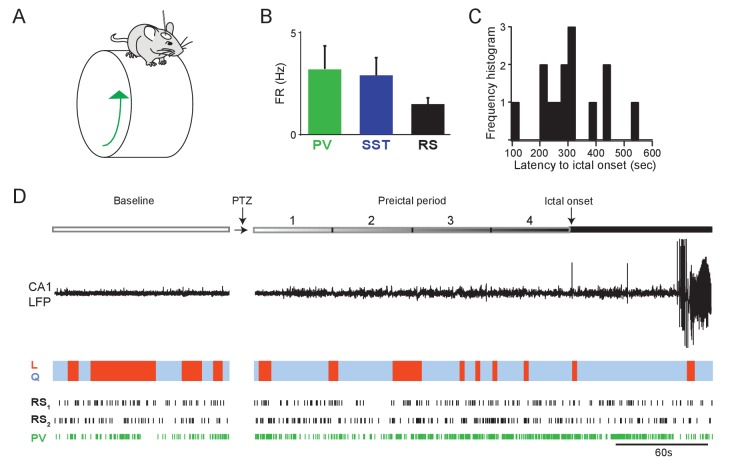
Preictal changes in interneuron activity during awake seizure initiation.(A) Schematic of head-fixed mouse on running wheel. Wheel motion was measured using a linear angle detector. (B) Mean baseline firing rates (Hz) were not significantly different between PV, SST and RS cells recorded from hippocampal CA1 during wakefulness. (C) Histogram of awake seizure latencies. (D) Upper: Schematic of experimental paradigm showing baseline, PTZ injection and preictal period leading up to ictal onset. Middle: LFP trace from hippocampal CA1 recording. Colored bar denotes behavioral state of the mouse, with blue indicating quiescent sitting periods (Q) and red indicating periods of locomotion (L). Lower: Spike trains for two example RS cells and one PV cell recorded in one animal during seizure initiation. Error bars denote S.E.M. *p<0.0125.